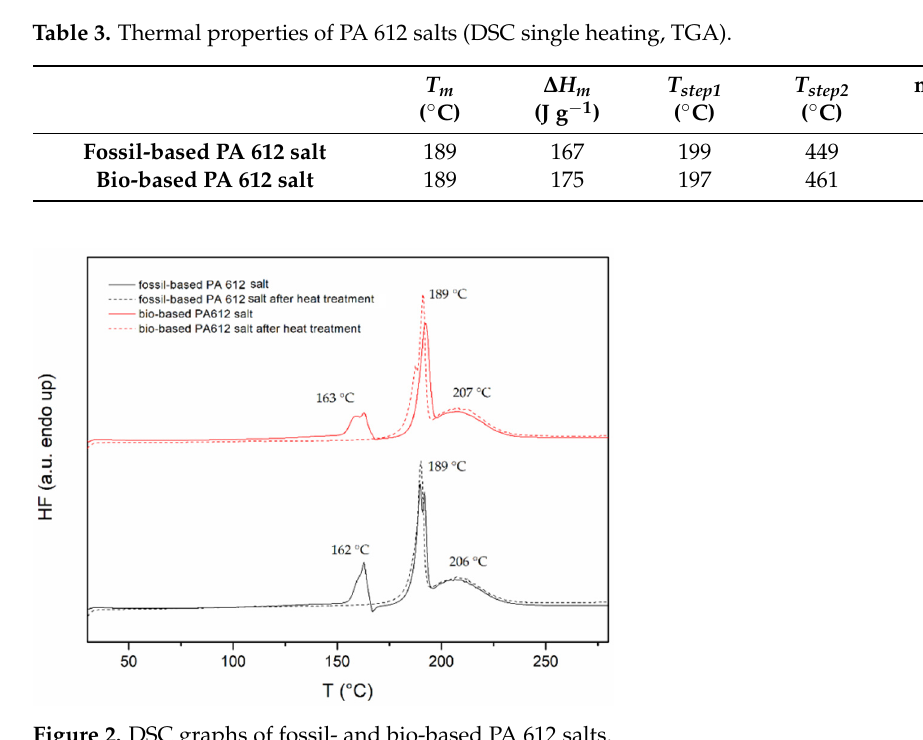
Figure 2. DSC graphs of fossil- and bio-based PA 612 salts.